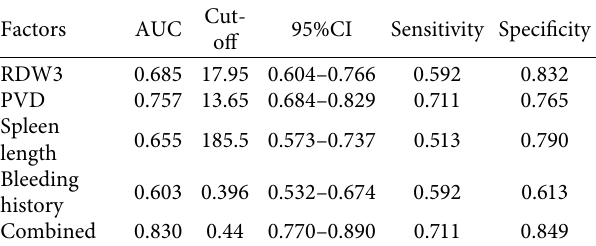
Figure 2: Receiver operating characteristic analysis of the inde- pendent risk factors. PVD: portal vein diameter, RDW3: red blood cell distribution width on postoperative day 3, and Combine: PVD +RDW3+ history of bleeding+spleen length. Table 3: AUC of the risk